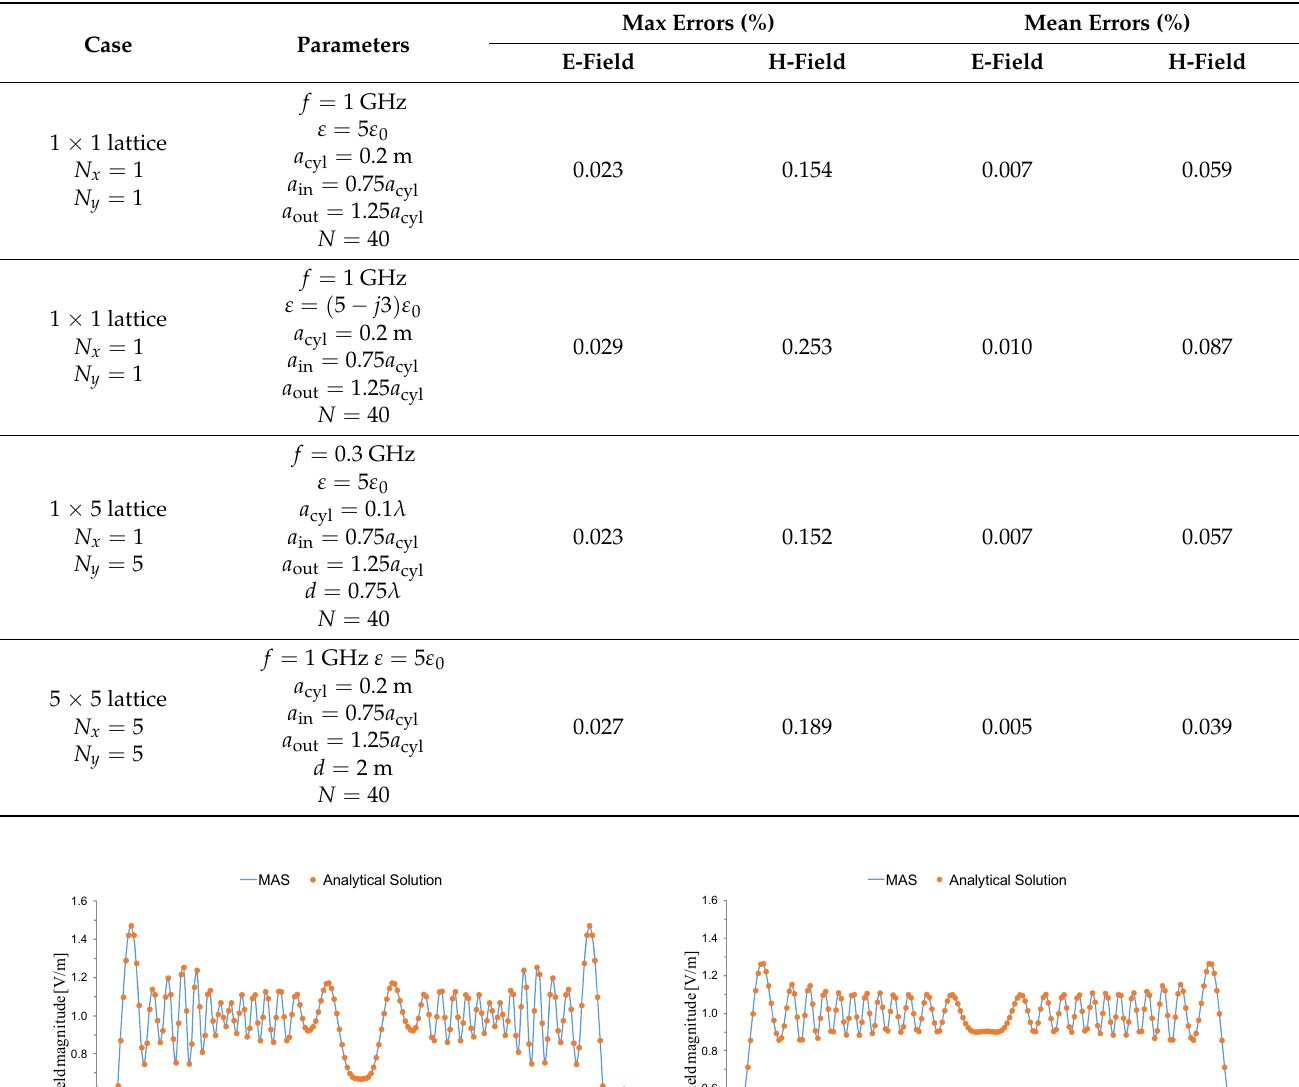
Table 1. Peak (max) and mean boundary-condition errors for various exemplary cases of lattices of dielectric cylinders.